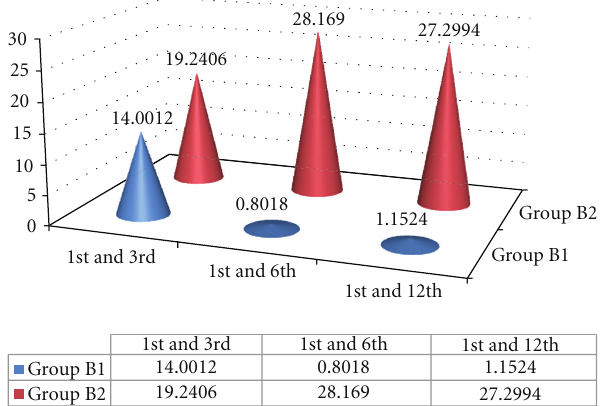
Figure 11: Comparison of Tabulated values of Position of GIngival Margin from Reference Stent (PGMRS) within B1 and B2 Group at various intervals of